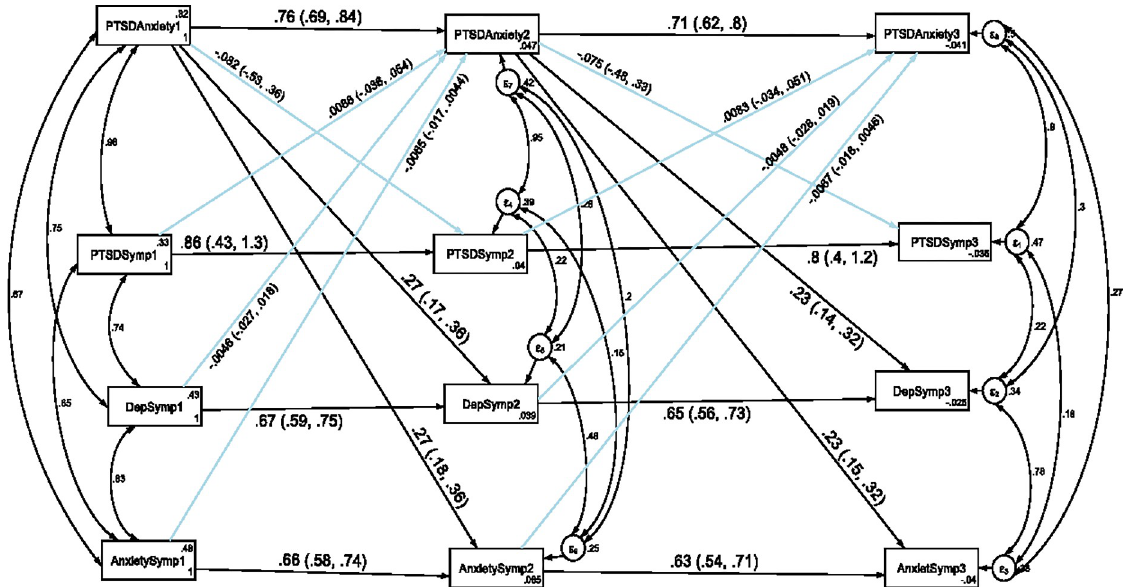
Fig 4. Longitudinal stability and cross-lagged association of depression, anxiety and PTSD with comorbidity of anxiety and PTSD. Note : All β ’s are standardized estimates with 95%